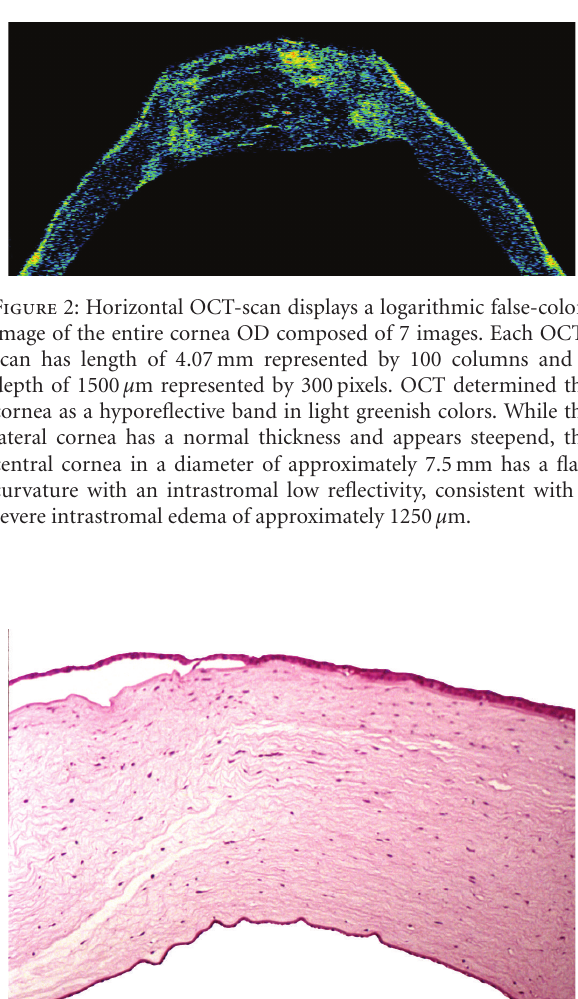
Figure 3: Light microscopy revealed a partially detached epithe- lium. The stromal architecture was rarified and the space between separate corneal lamellae edematous swollen. The descement and endothelial appeared